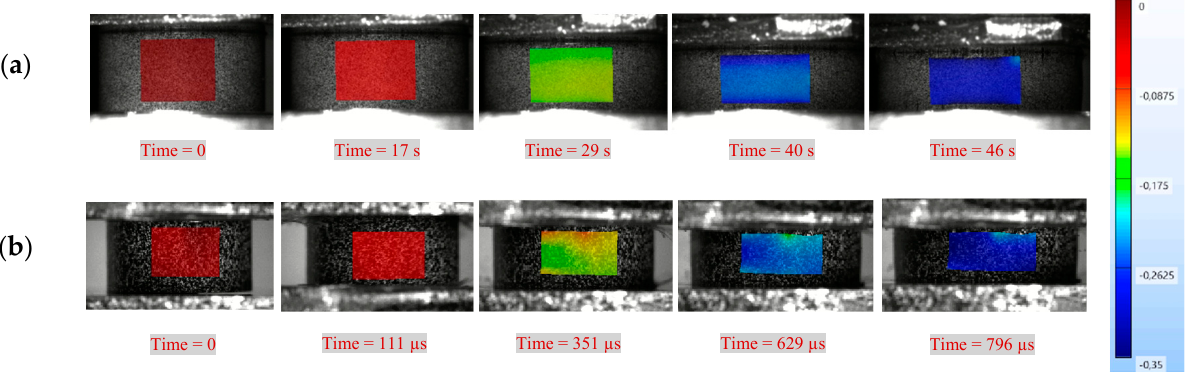
Figure 11. Evolution of axial true strain fields during compression testing: ( a ) a quasi-static test at 0.008 s − 1 , ( b ) a high strain rate test at 428 s − 1.